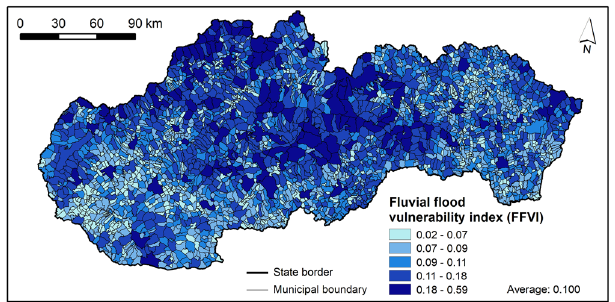
Figure 12. FFVI in municipalities of Slovakia. This figure was generated in ArcGIS 10.2.2 software.